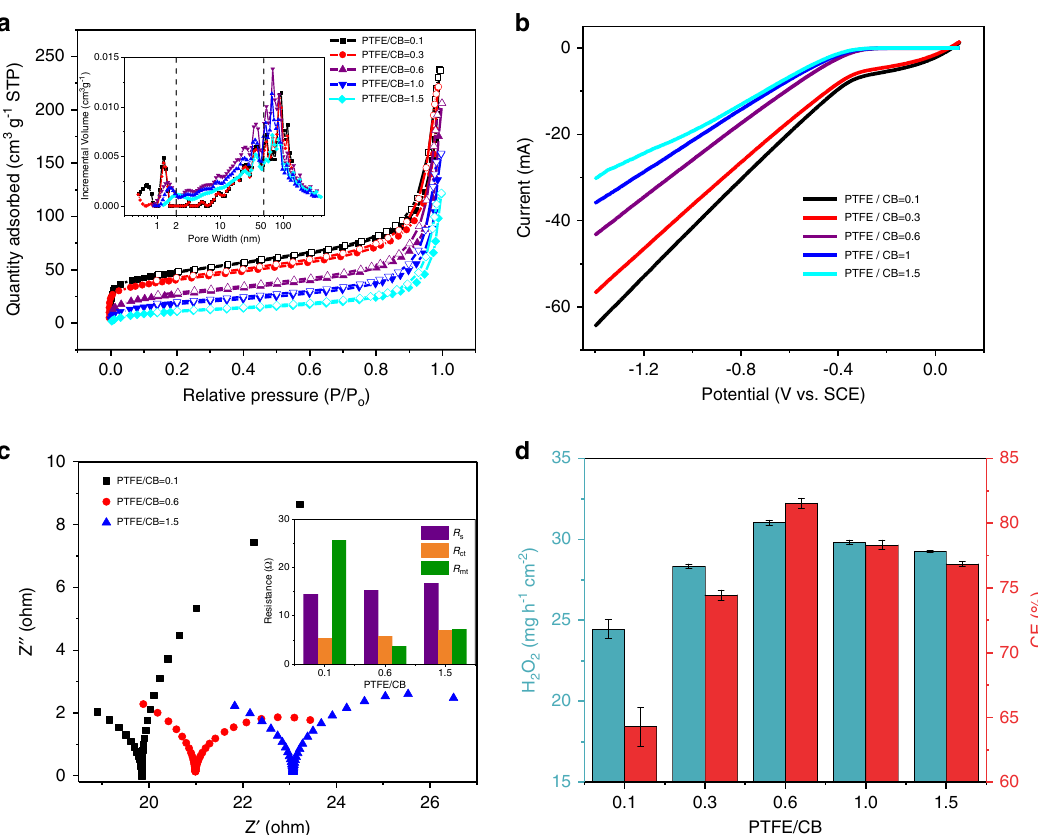
Fig. 2 Characterization and H 2 O 2 production of different NADEs. a N 2 adsorption – desorption isotherms and pore-size distribution (inset) of catalytic layer materials with different PTFE/CB mass ratios. b LSV and c Nyquist plots/ fi tted curves of catalytic layer materials with different PTFE/CB mass ratios. d Performance comparison of different PTFE/CB NADEs for H 2 O 2 generation and current ef fi ciency at the current density of 60 mA cm − 2 . The error bars represent the standard deviation of three independent samples. Source data are provided as a Source Data fi